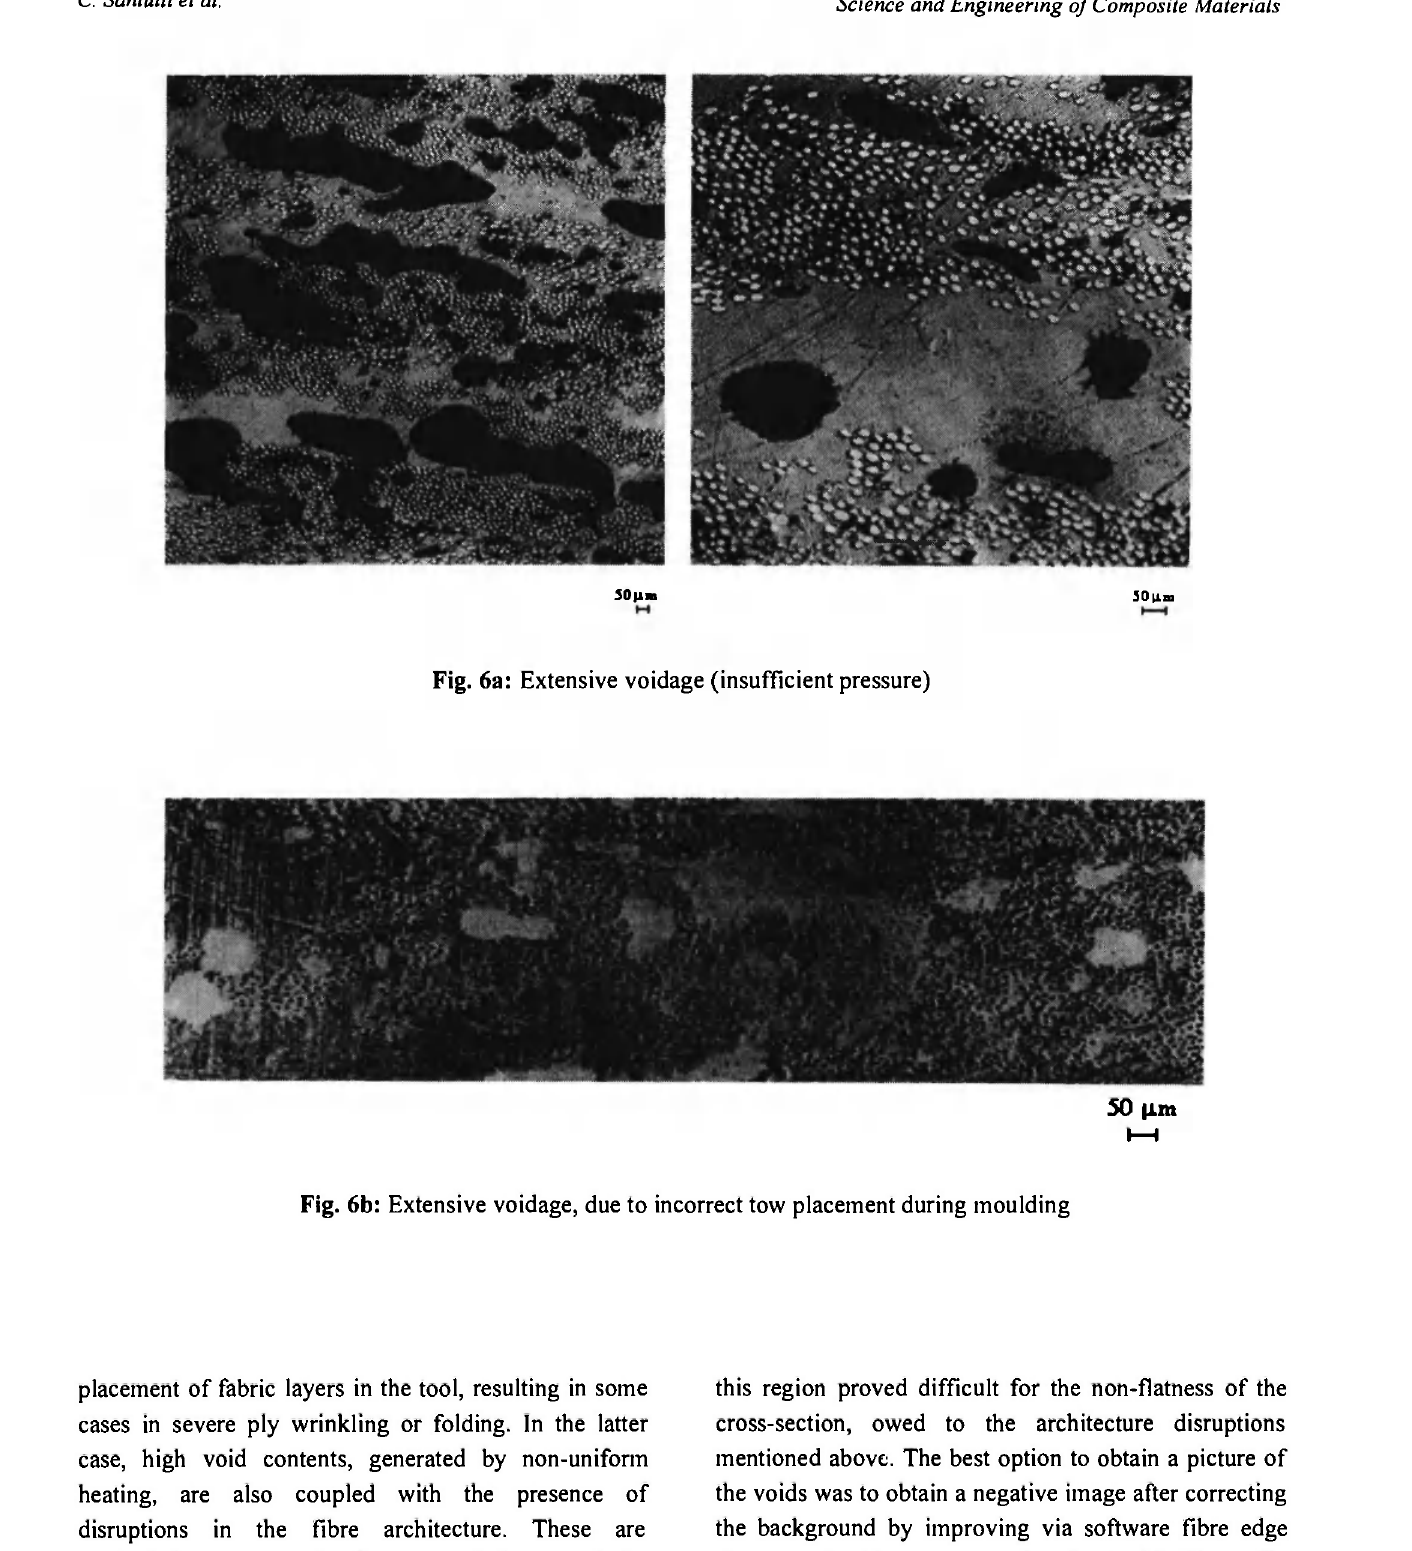
Fig. 6b: Extensive voidage, due to incorrect tow placement during